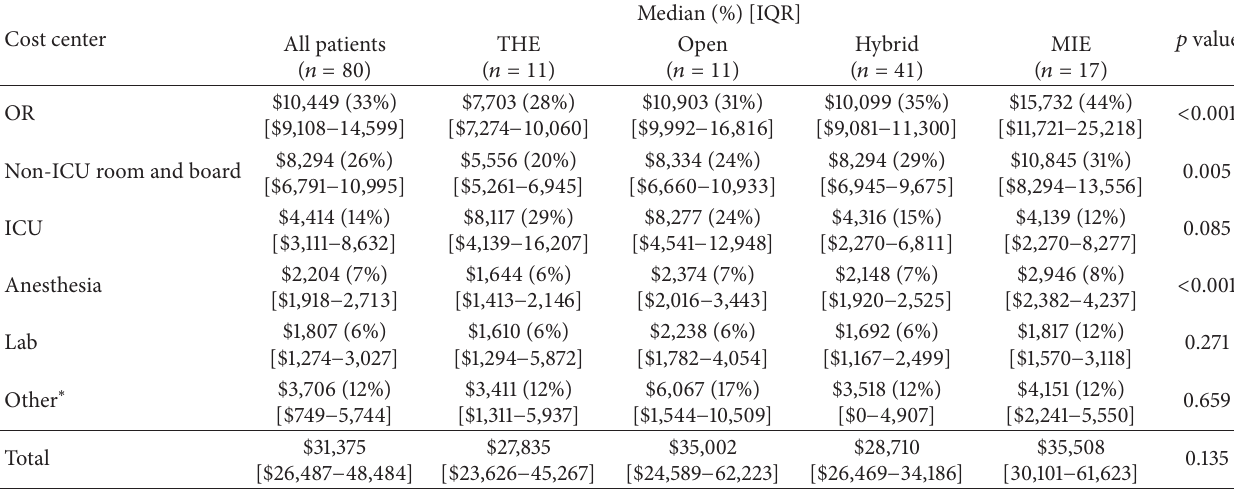
Table 2: Median cost (% of total cost) [ IQR ] by cost center.